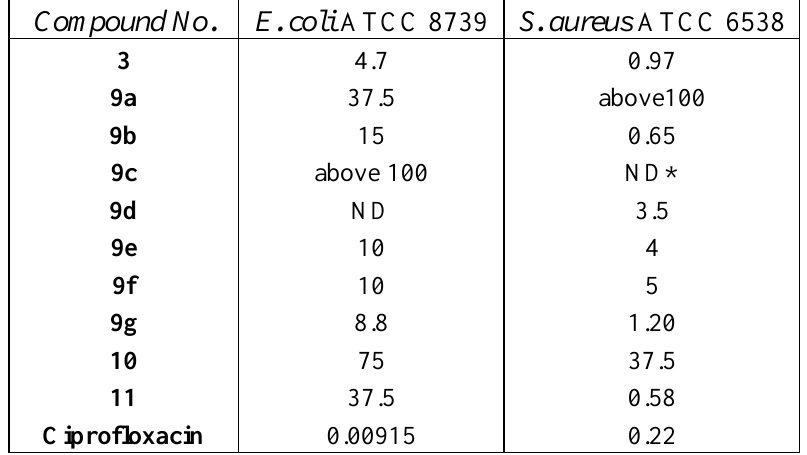
Table 2. MIC for the prepared 8-nitrofluoroquinolones against E. coli and S. aureus. Compound